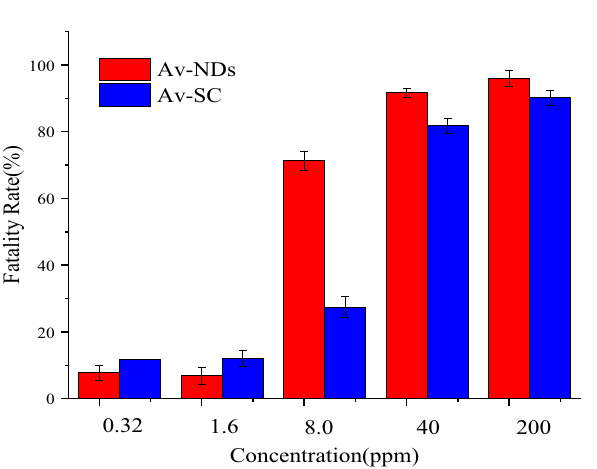
Figure 11. Comparison of toxicity of Av-NDs and Av-SC to Mythimna separata at different